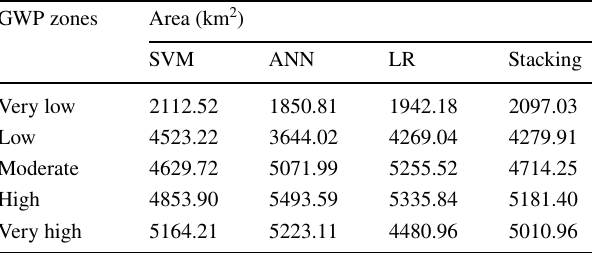
Table 3 Area coverage of hybrid models under different GWP zones GWP